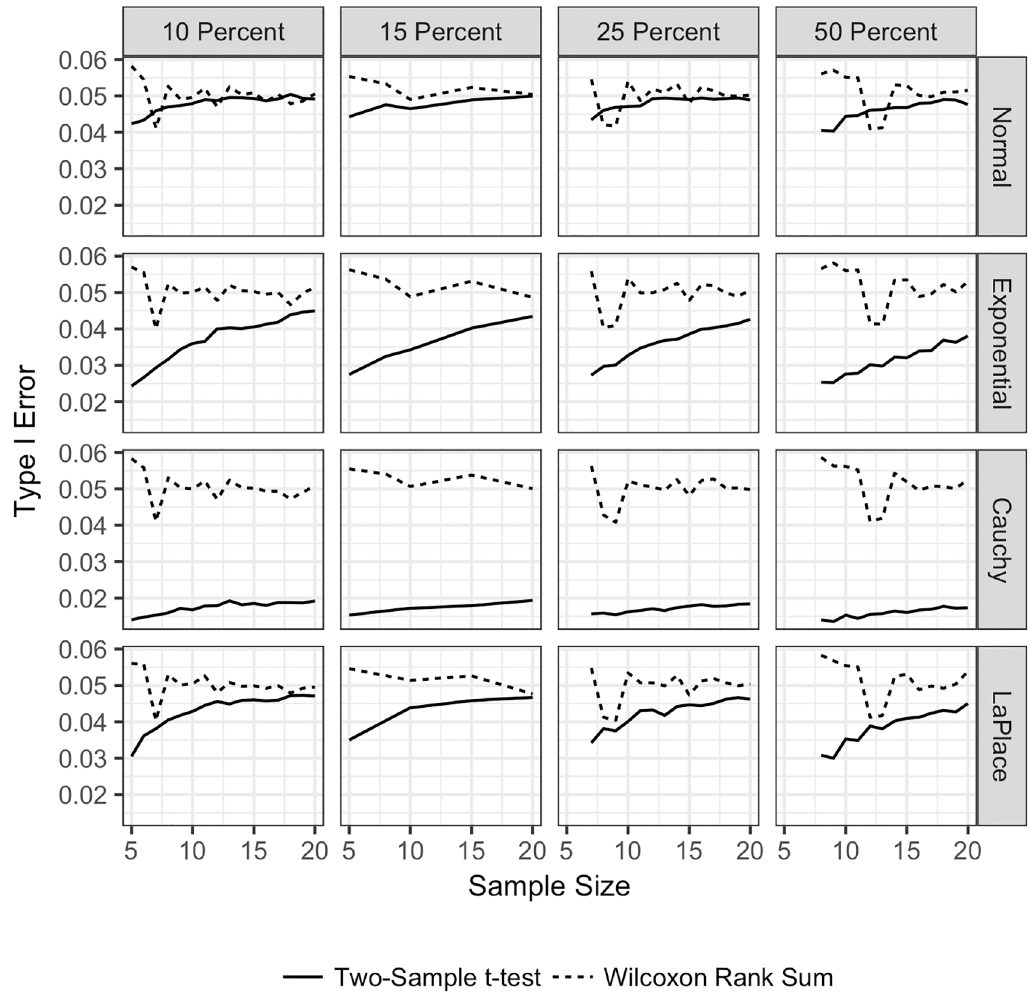
Fig 5. Type I error TST and WMW omitting tied observations. Type I error for both the TST and WMW when tied observations are omitted, when 10% (far left column), 15% (second column), 25% (third column), and 50% (far right column), of the observations are tied; sample sizes are equal; and all distributions are continuous. Type I error is plotted on the vertical axis, and the sample size for one sample is plotted on the horizontal axis. The Type I error for the TST is plotted with a solid line ( ) , and the Type I error for the WMW is plotted with a dashed line ( ) Each row corresponds to a different underlying population distribution: the Normal (top row), exponential (second row), Cauchy (third row) and Laplace (bottom row). Each frame shows the empirical Type I error under each combination of distribution and percentage of tied observations.